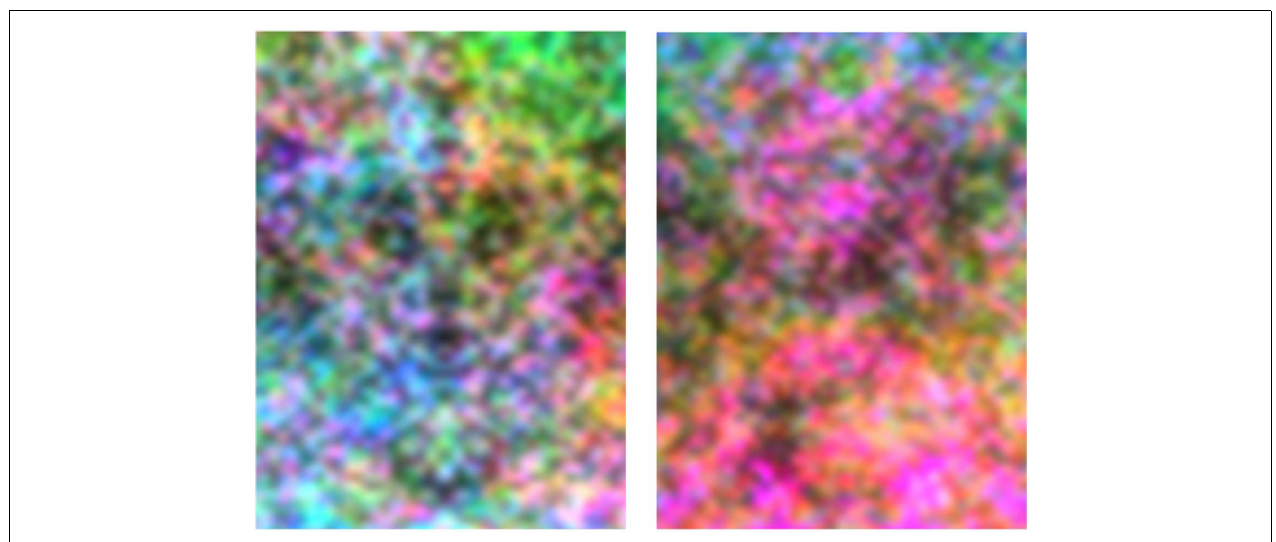
FIGURE 8 |An example of images with symmetric luminance contrast and random chromatic contrast (left), or symmetric color and random luminance